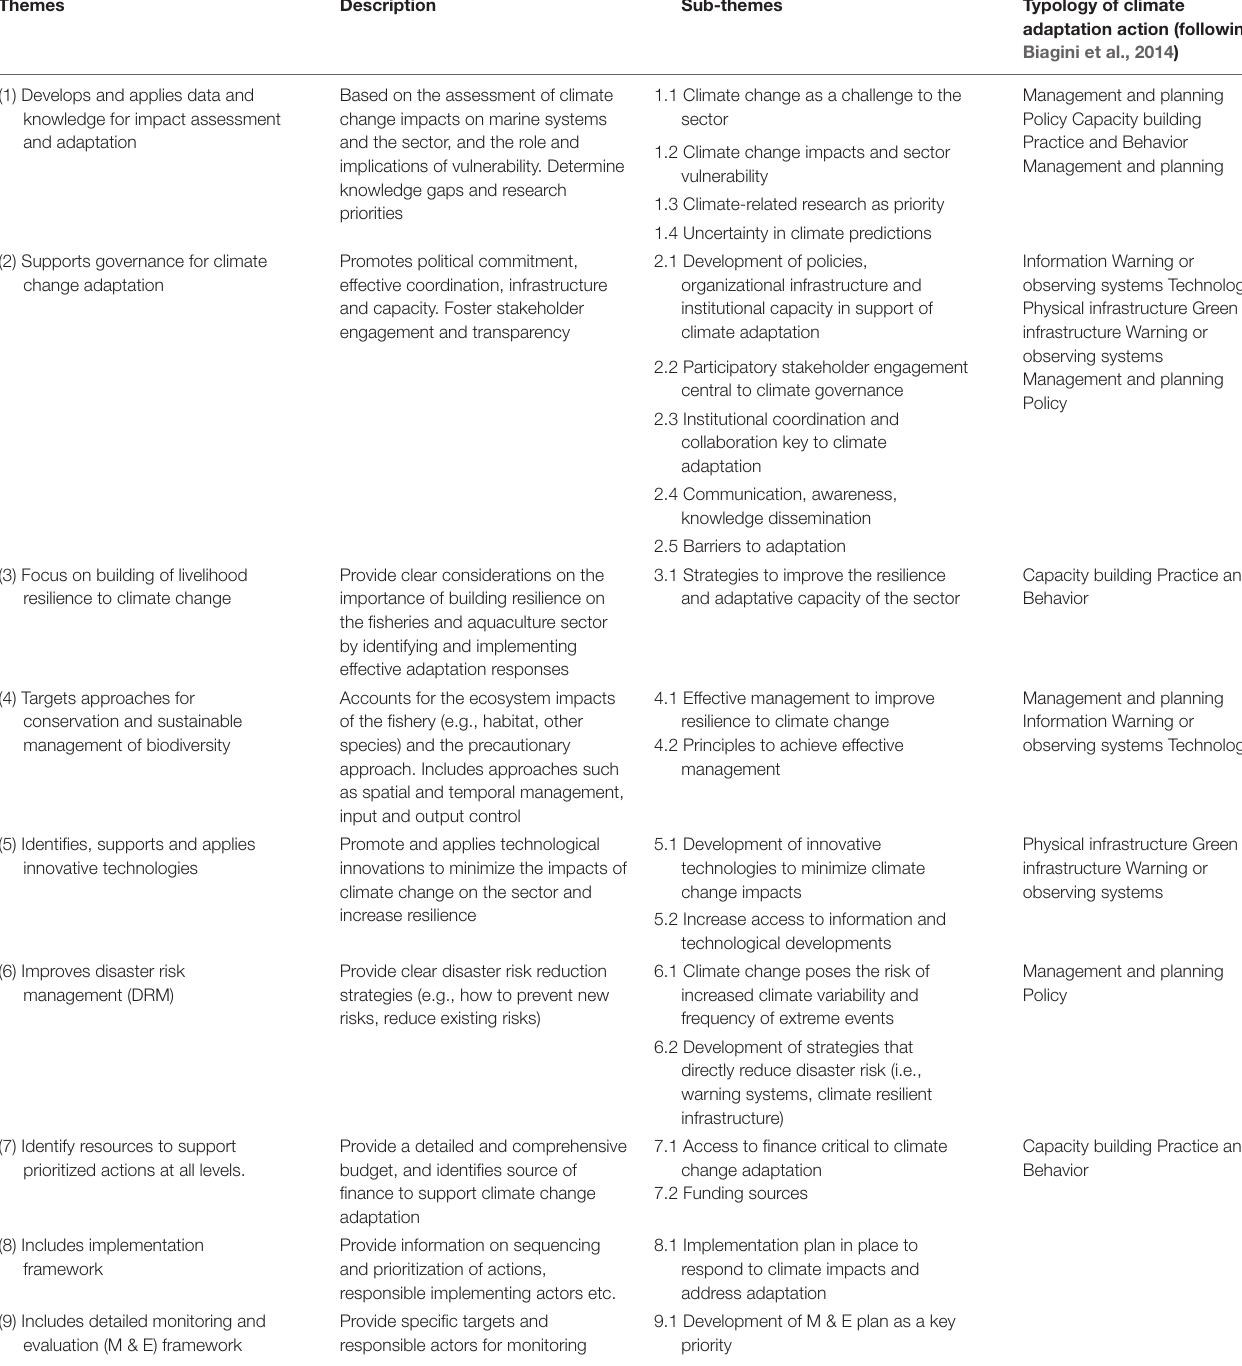
TABLE 2 | Themes, description and sub-themes used to determine the adequacy of fisheries documents to incorporate climate